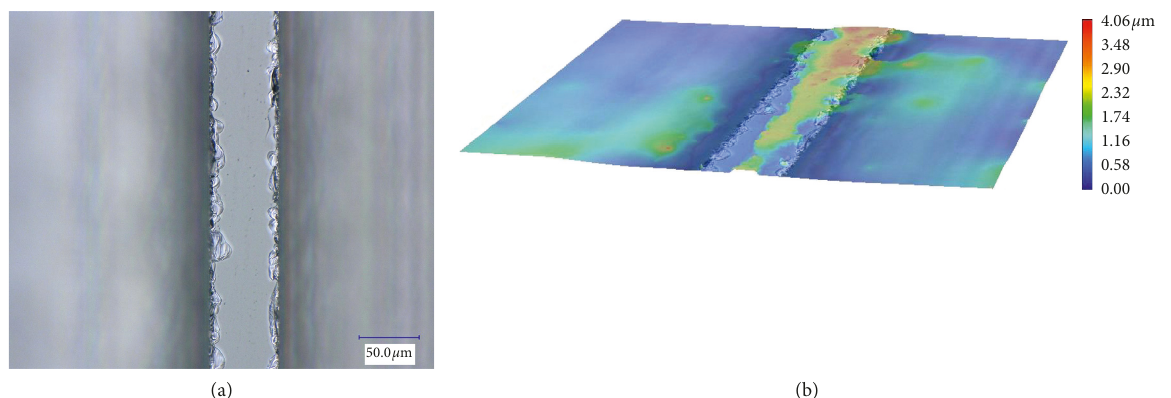
Figure 9: 3D topography of sample